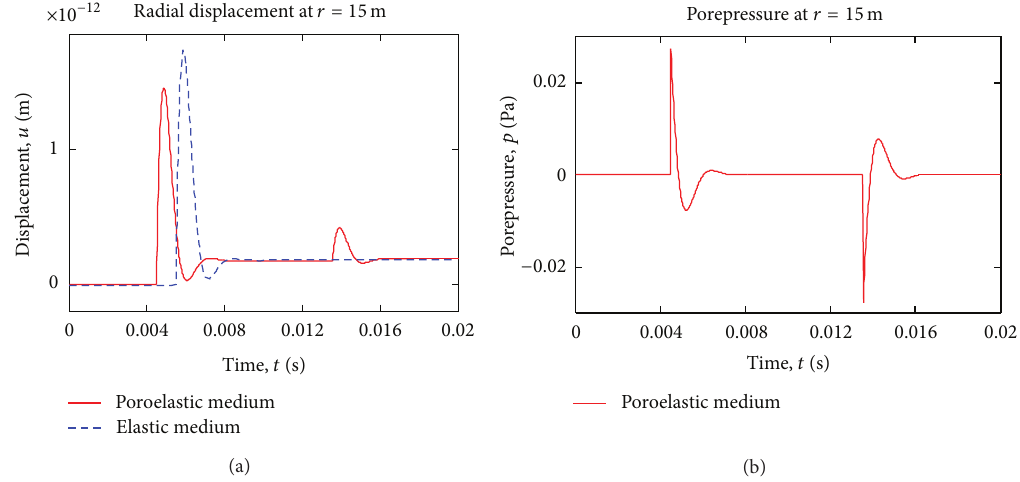
Figure 5: Time variation of radial displacement and pore pressure, step (Heaviside) pulse case.